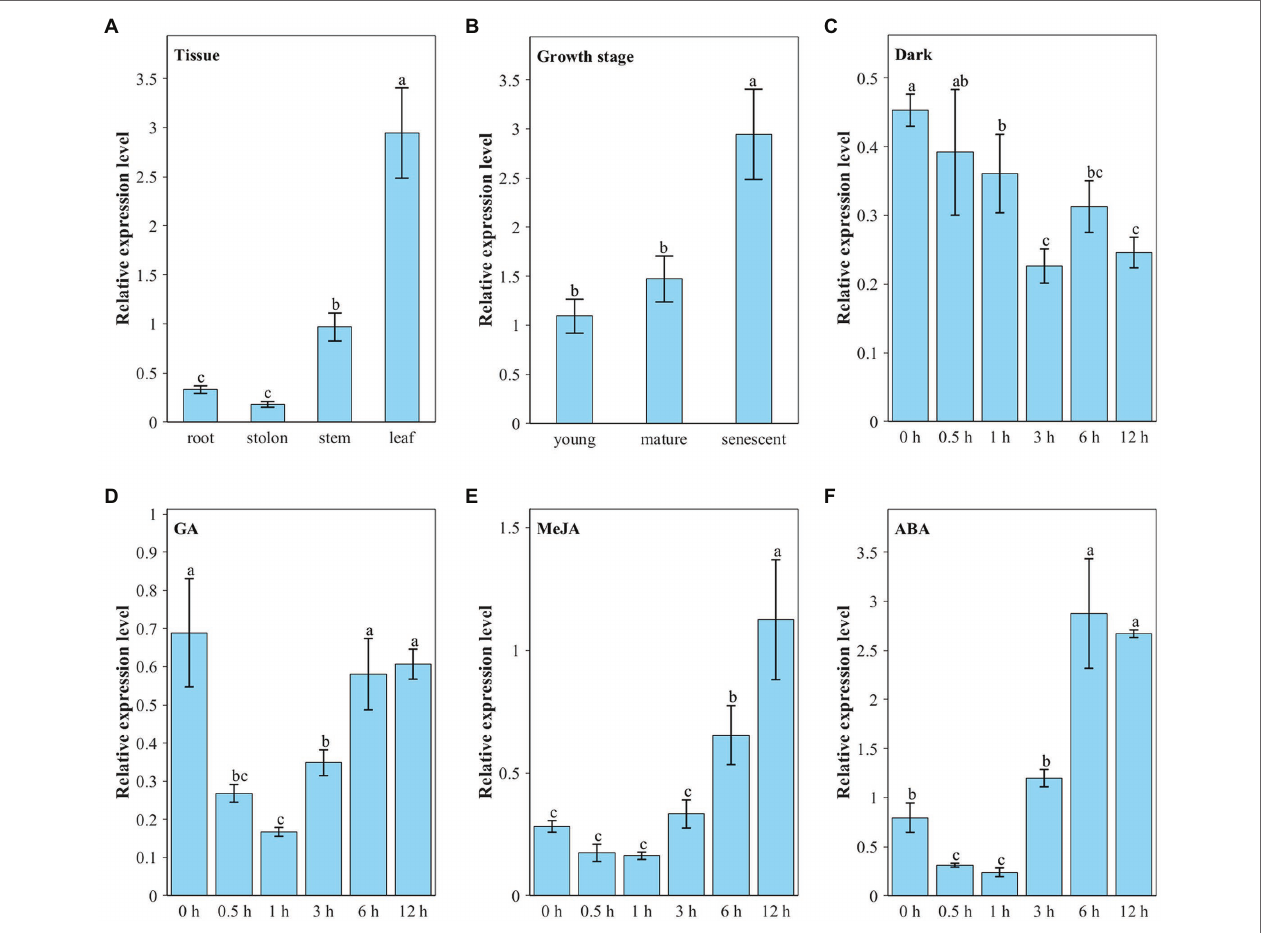
FIGURE 3 | Transcriptional expression characters of ZjNOL . (A) Different tissues; (B) leaves at different growth stages; continuous expression tendency under different treatments: dark (C) , GA (D) , MeJA (E) , and ABA (F) . Data were expressed as mean ± SD ( n = 4). Different letters indicate significant differences at p ≤ 0.05 based on Fisher’s protected least significant difference (LSD)